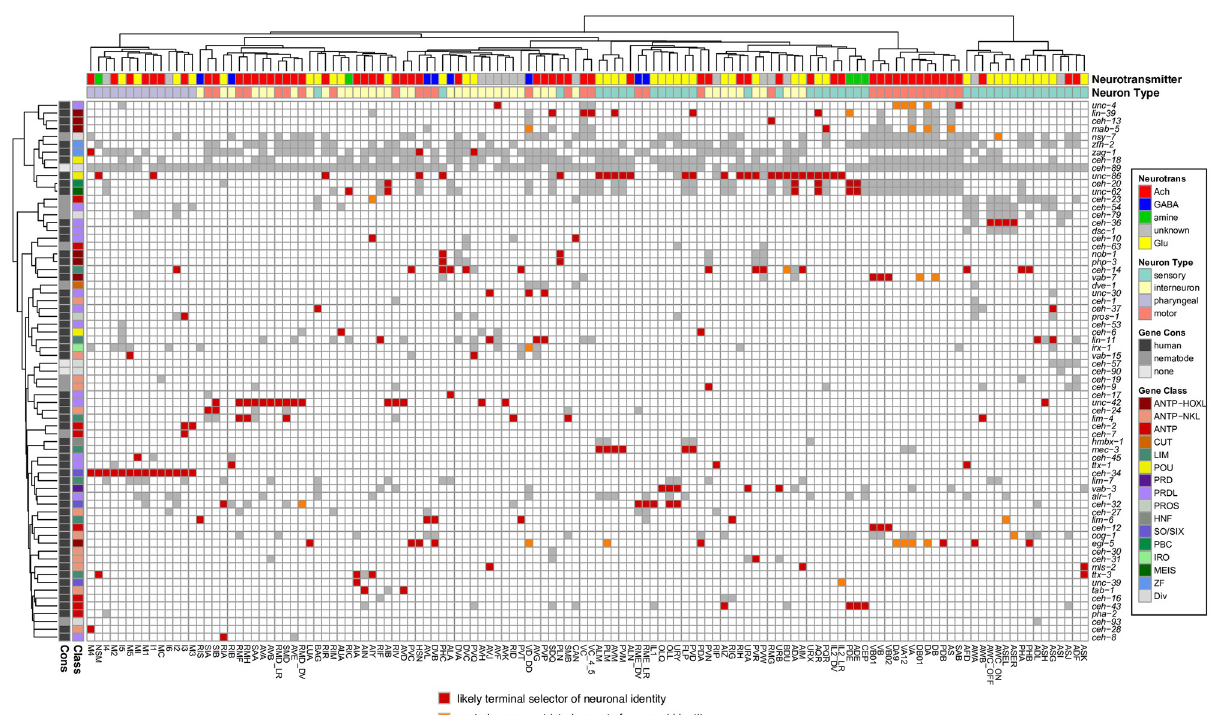
Fig 13. Regulation of neuron identity across the C . elegans nervous system by homeodomain transcription factors. Functional analysis of homeobox gene family, overlayed onto the homeobox expression matrix from Fig 1B. Red boxes indicate that a homeodomain transcription factor is expressed in and likely acts as a terminal selector for a given neuron type (based on extent of functional marker analysis). Orange boxes indicate that a homeodomain transcription factor has a more restricted function in a given neuron class. Gray boxes indicate that a homeodomain transcription factor is expressed in that given neuron type, but not necessarily functionally analyzed and white boxes indicate that a homeodomain transcription factor is not expressed in that given neuron type. Panneuronal and non-neuronal homeoboxes were excluded from this representation because they do not contribute to unique neuron type codes. Neuron types along the x axis are clustered by transcriptomic similarity using the Jaccard index (see methods) and homeobox genes along the y axis are clustered similarly by their similar expression profiles in shared neuron types. See S4 Table for tabular list of genes and cells on which this matrix is